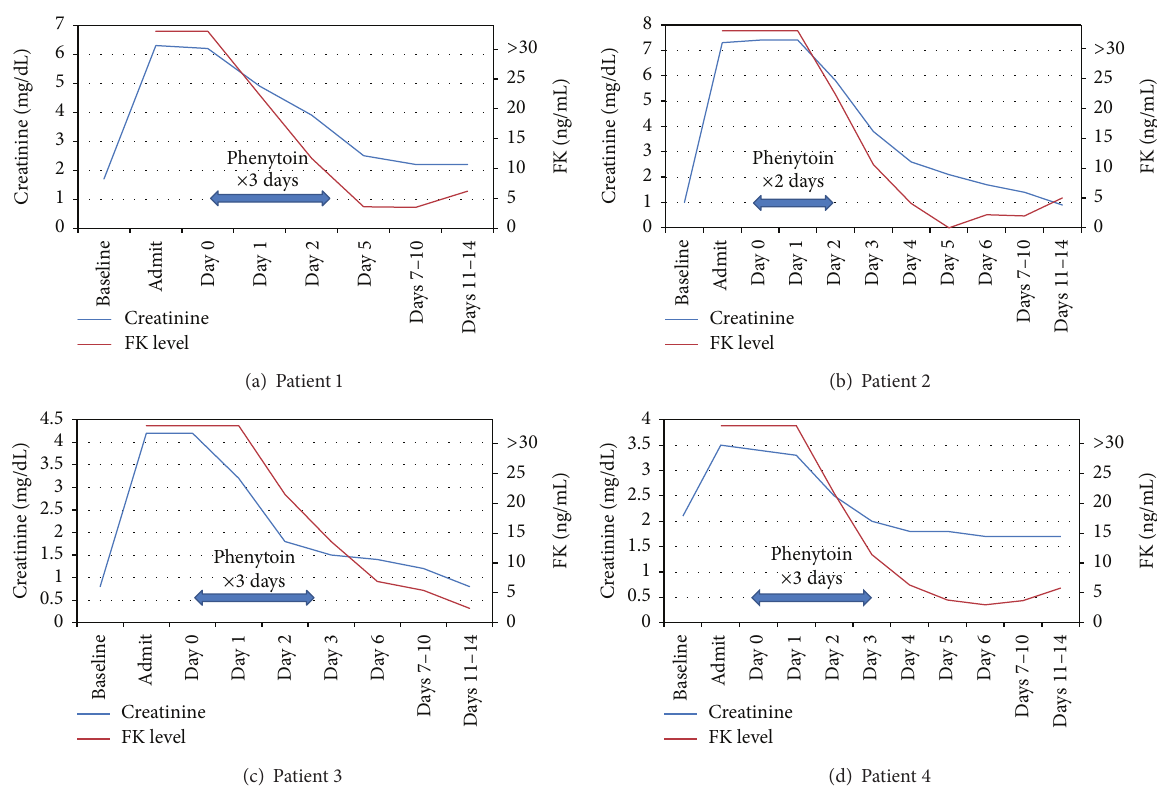
Figure 1: Mean creatinine and FK levels. Day 0 represents first day of phenytoin